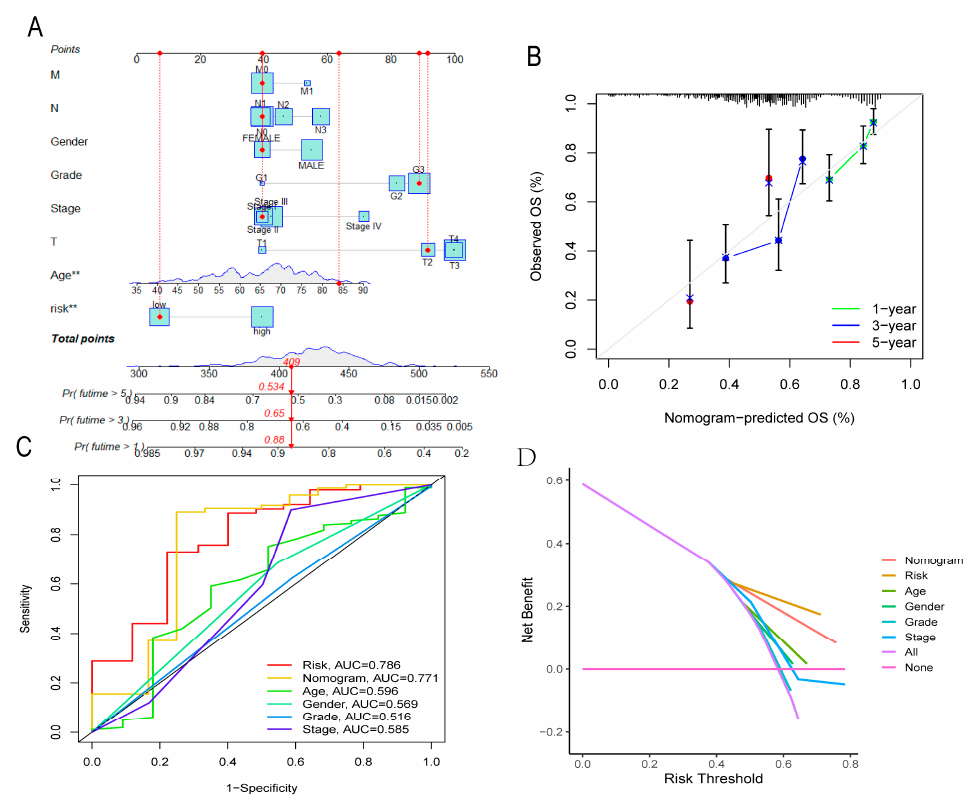
Figure 8. Nomogram and identification. ( A ) Nomogram. ( B ) The calibration curve determines the stability of the nomogram. ( C , D ) Multi-index ROC curve and DCA decision curve show better predictive ability of nomogram and risk score. (all p <